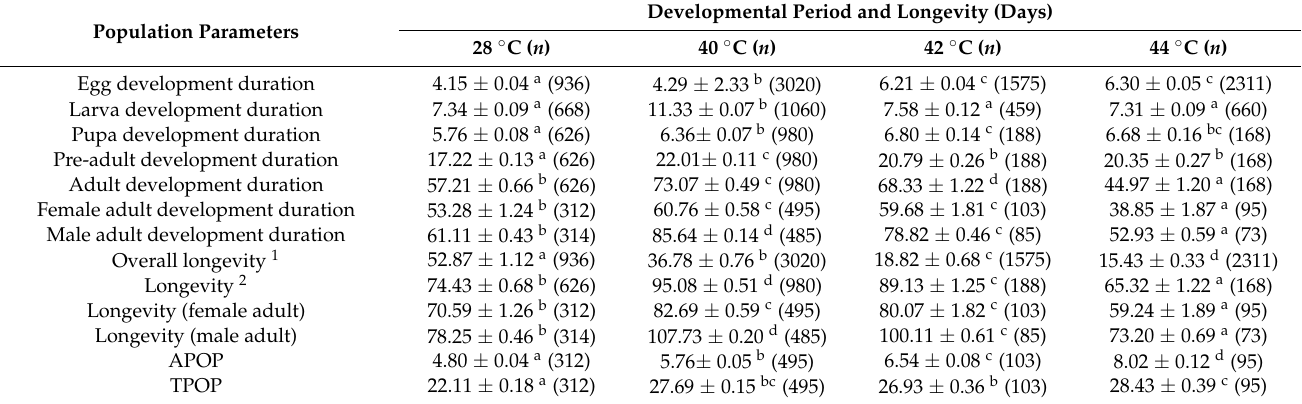
Table 1. Effects of periodical exposure to high temperatures on the life cycle of the ragweed beetle Ophraella communa .